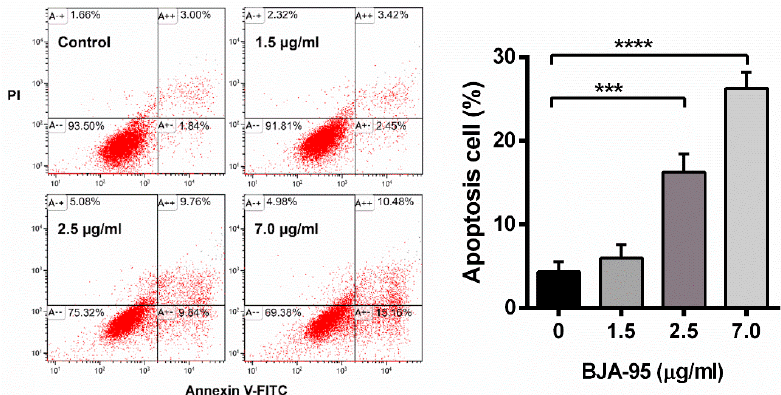
Figure 2. Apoptosis induction by BJA in CCA cells. KKU-213 cells were treated with indicated concentrations of BJA-95 for 24 h. Cells were stained with annexin V-fluorescein isothiocyanate and propidium iodide (annexin V-FITC / PI) and analyzed by flow cytometry. The bar graph